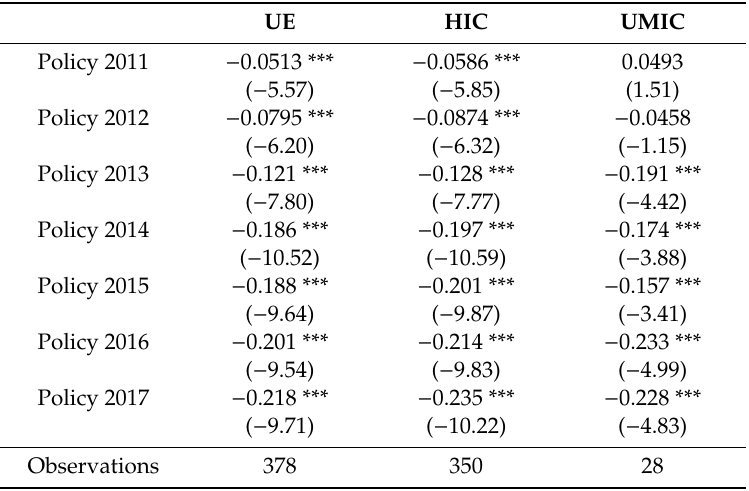
Table 8. Policy e ff ects on CO 2 emissions over